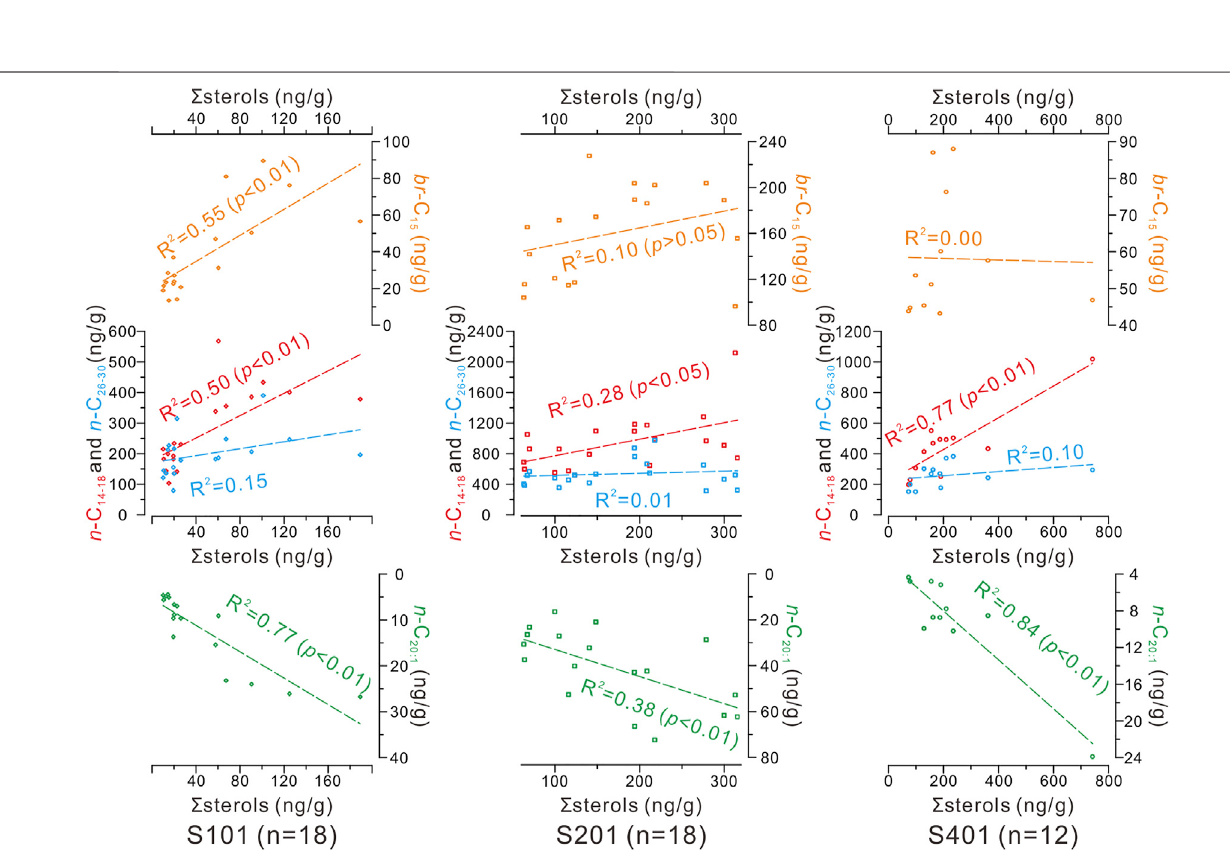
Frontiers in Earth Science |